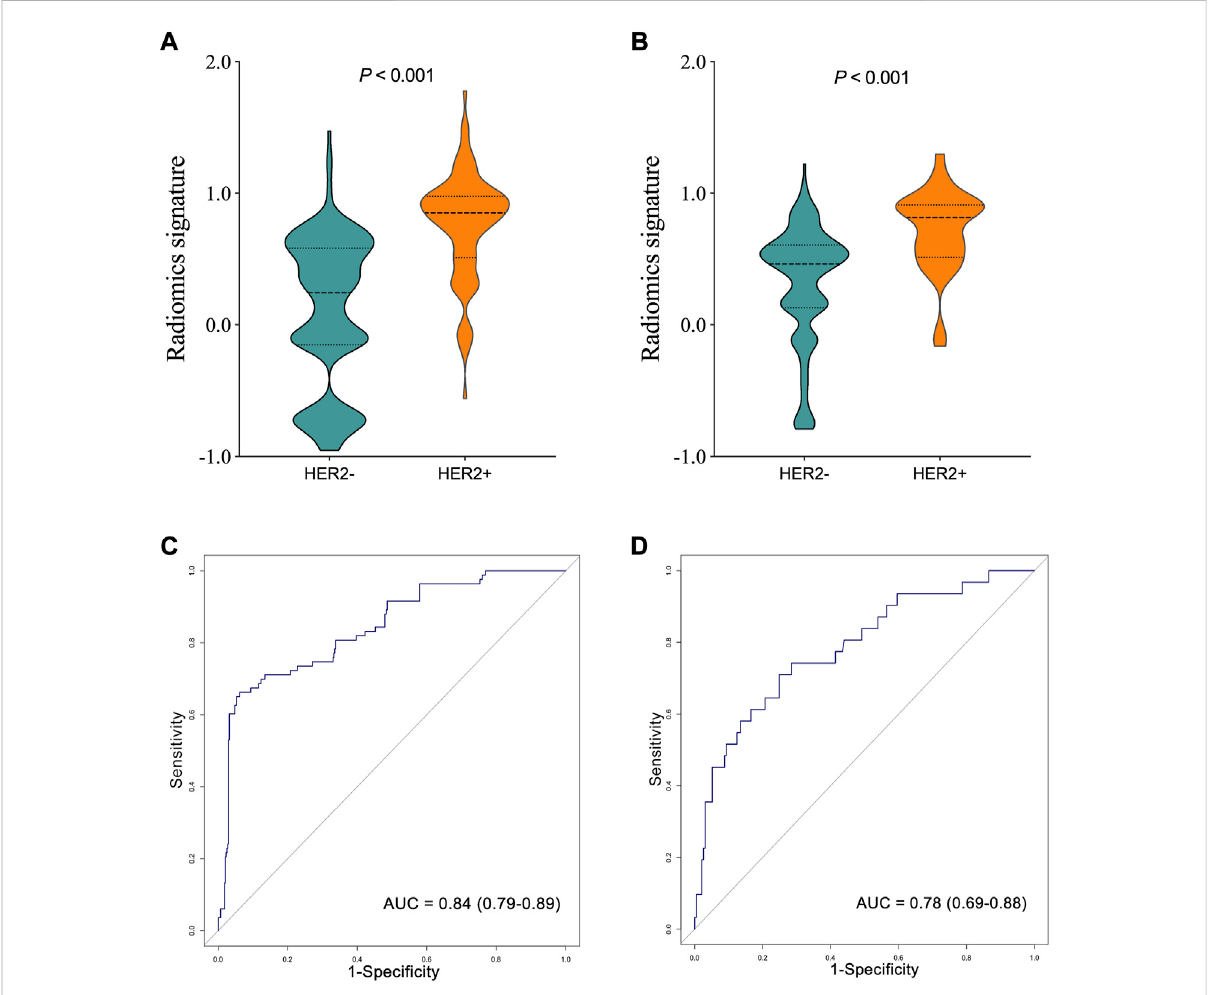
FIGURE 3 Comparison ofradiomicsscorebetweenhumanepidermalgrowth factorreceptor2(HER2) — andHER2+groupsinthetraining (A) ,andtesting (B) sets. The ROC curves of the radiomics signature in the training (C) , and testing (D) sets.